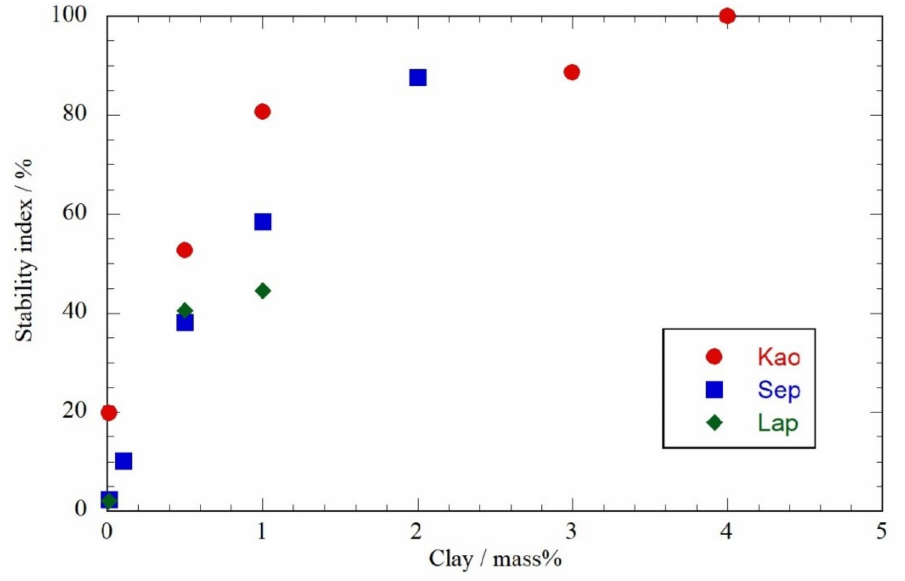
Figure 1. Pickering emulsion stability index as functions of clay